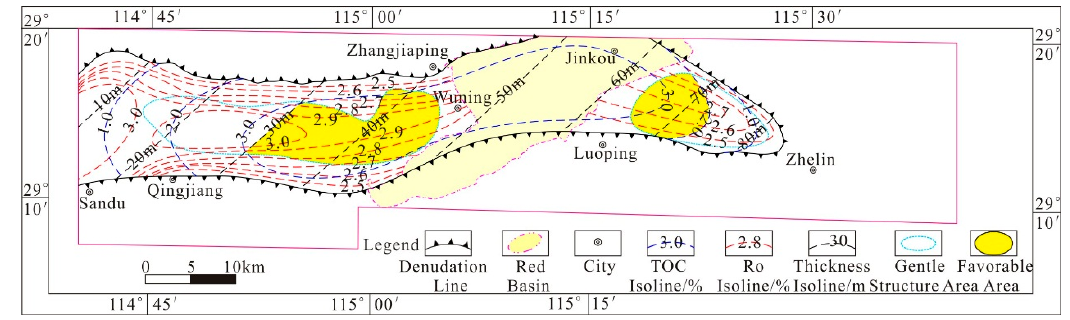
Figure 15. The optimization of favorable shale-gas areas for the Xinkailing formation in Wuning district.